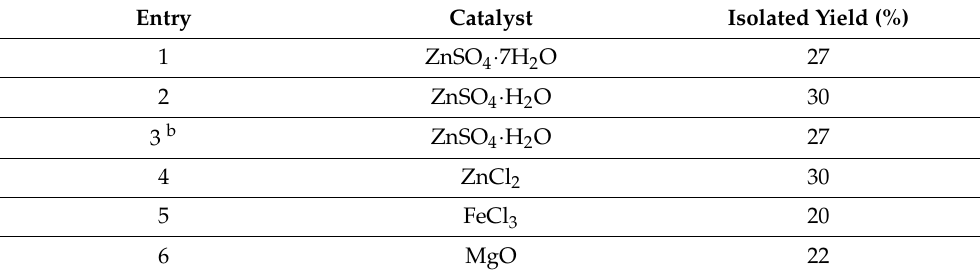
Table 1. Screening of alternative catalysts in the batch conversion of Gly to GC a . Entry Catalyst Isolated Yield